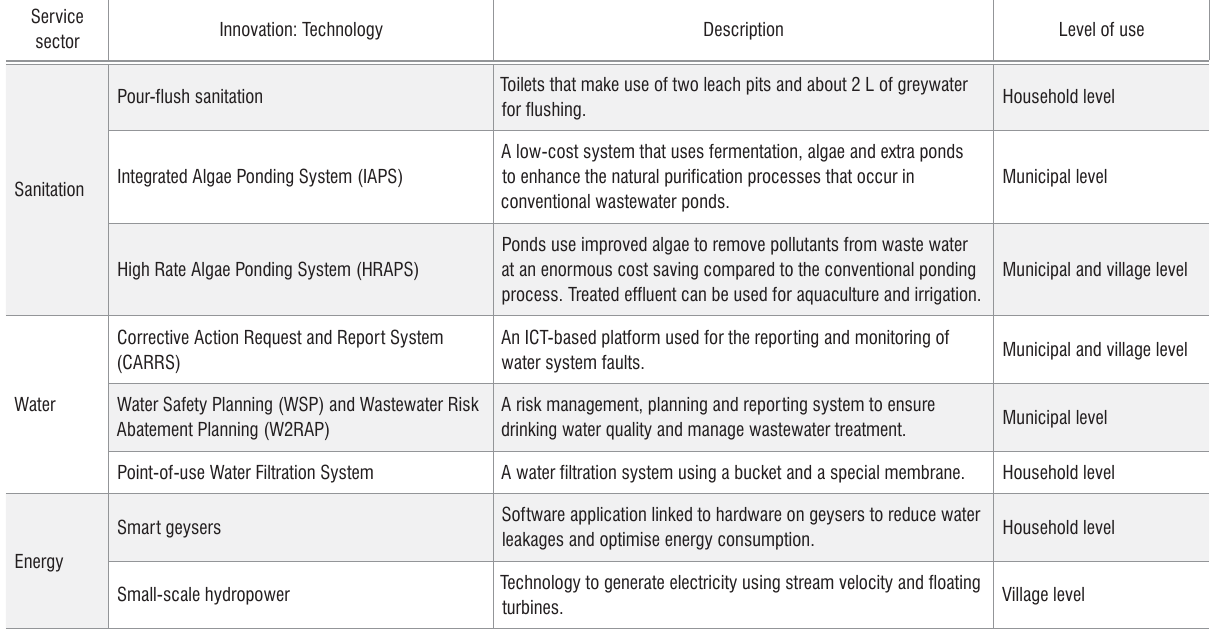
Descriptions of the IPRDP Innovations and the level of demonstration Service sector